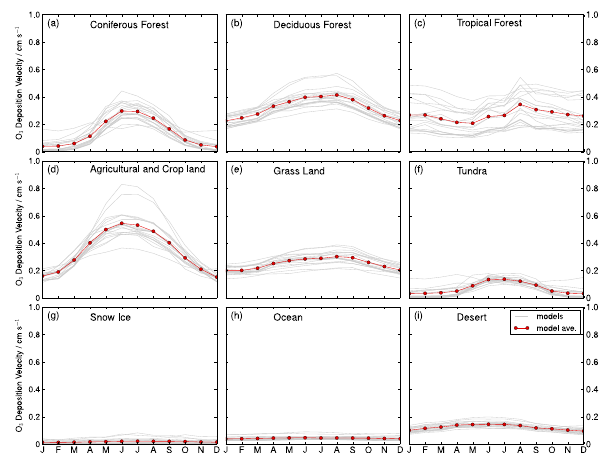
Figure 3. Average monthly O 3 dry deposition velocities at grid cells with 100% coverage of a given land cover class. Model deposition velocities are shown in grey and the ensemble average in